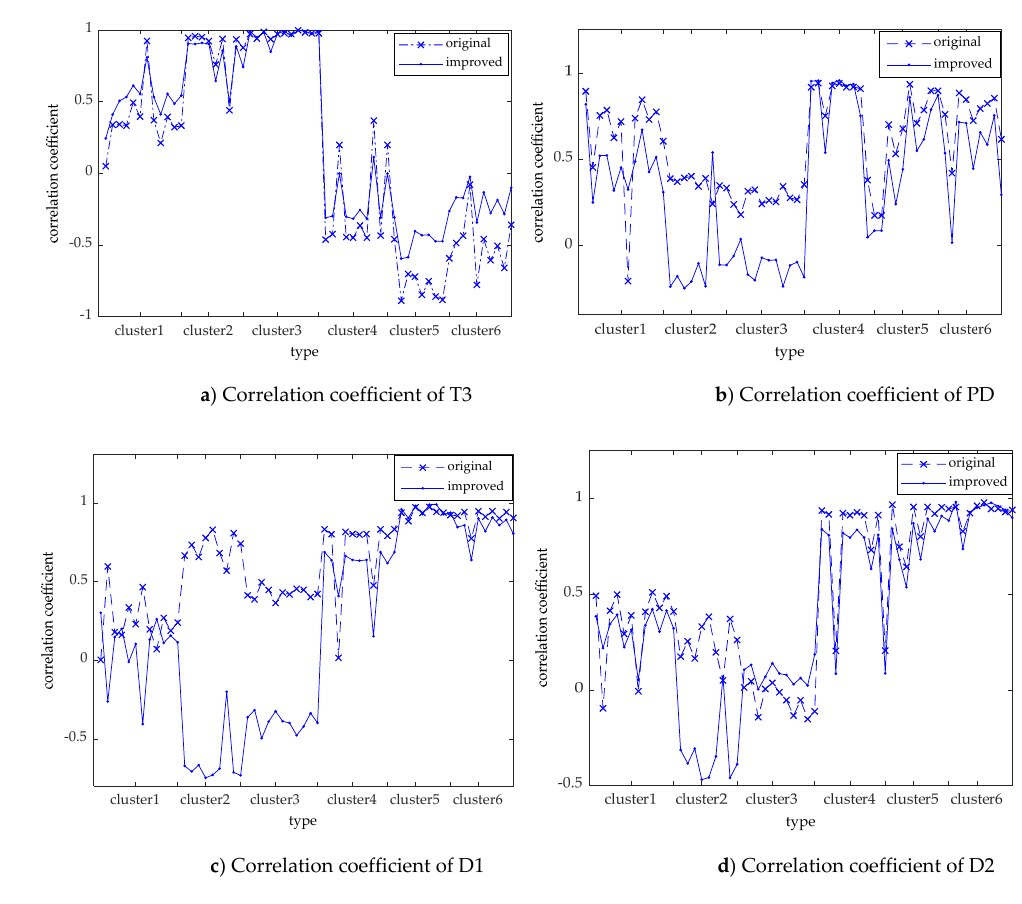
Figure 8. Line chart of correlation coe ffi cient before and after improvement. ( a ) Correlation coe ffi cient of T3; ( b ) Correlation coe ffi cient of PD; ( c ) Correlation coe ffi cient of D1; ( d ) Correlation coe ffi cient of D2.